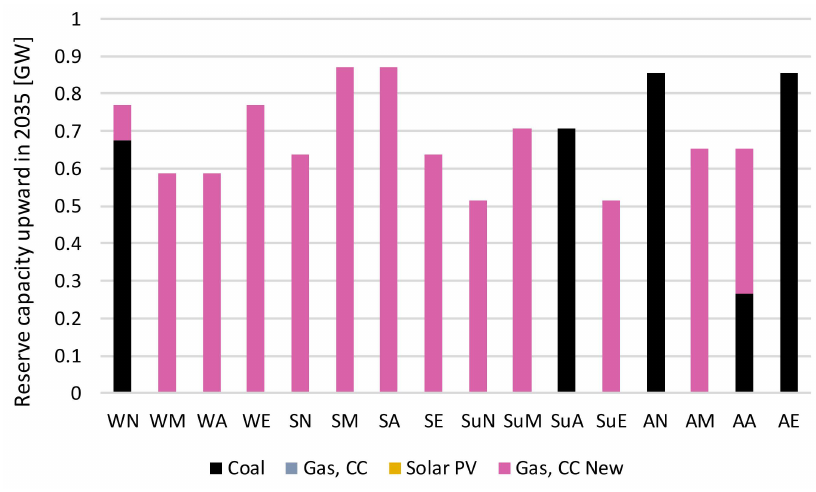
Figure 13. Reserve capacity supply (GW) per time slice in 2035 in the REF scenario—with code modifications.